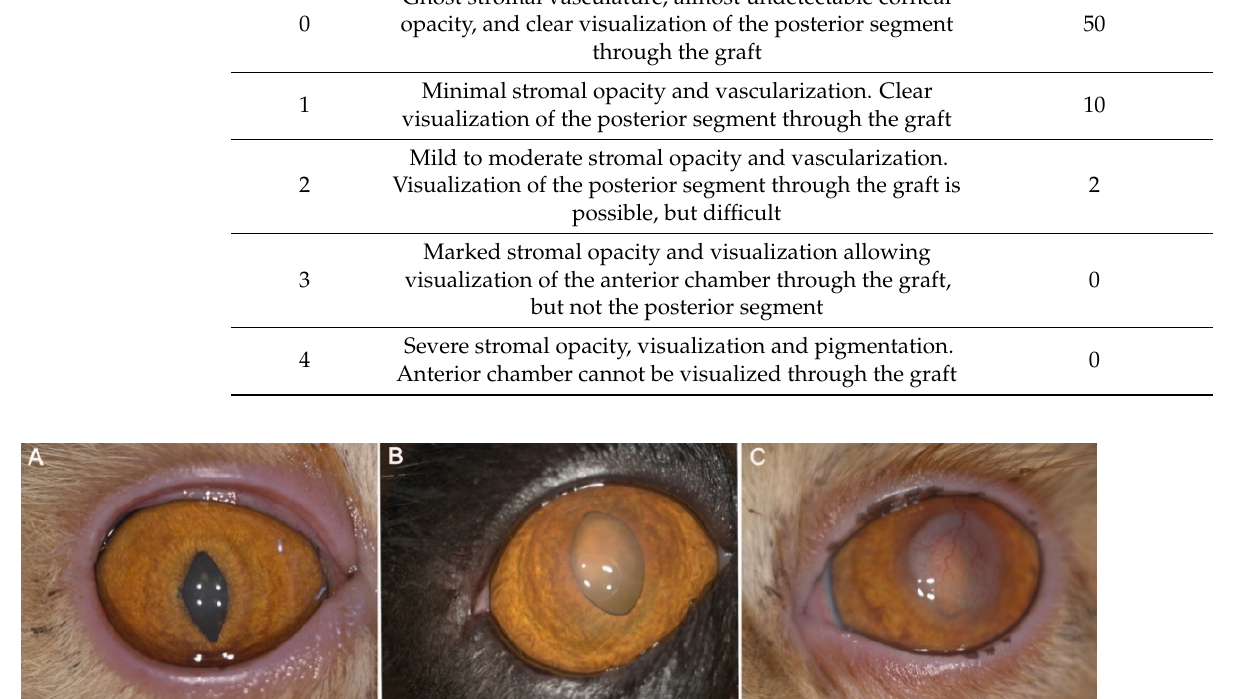
Figure 5. Good and satisfactory examples of functional and cosmetic outcomes. ( A – D ) Case number: 11 (24 months post-op), 26 (14 months post-op), 32 (6 months post-op) and 33 (11 months post-op). Table 1. Grade of transparency of the cornea. Grade Description Number of Eyes Figure 4. Grading of corneal healing after BioCorneaVet TM lamellar keratoplasty. ( A ) Grade 0, almost invisibility of corneal scarring and vessels; ( B ) Grade 1, minimal corneal stroma opacity and vascularization; ( C ) Grade 2, mild to moderate corneal stroma opacity and vascularization; ( A – C ) Case number: 3, 2 and 8.